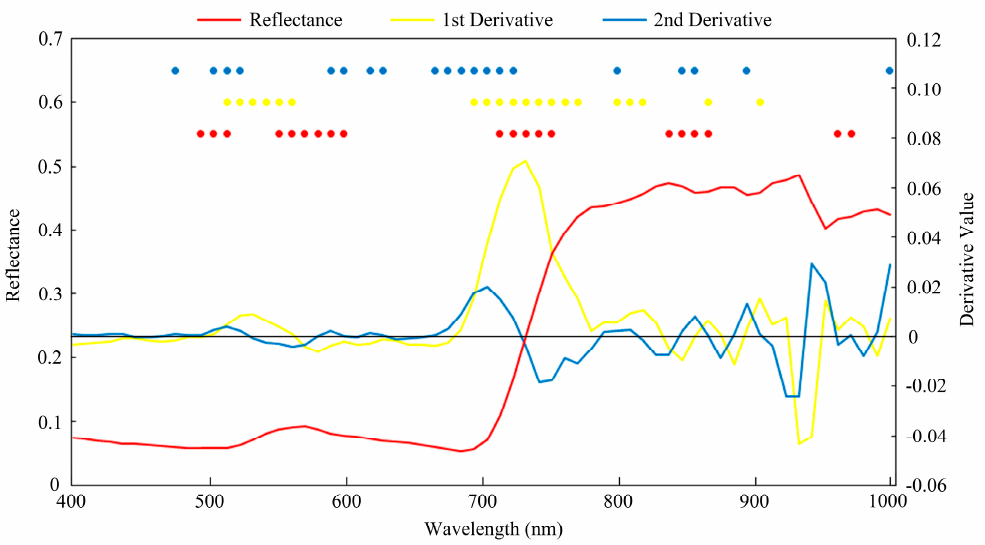
Figure 6. Mean spectral reflectance and derivative curves for all sunlit crowns of five tree-species. Dots with the same color above curves represent the best 20 bands selected by PCA procedure.